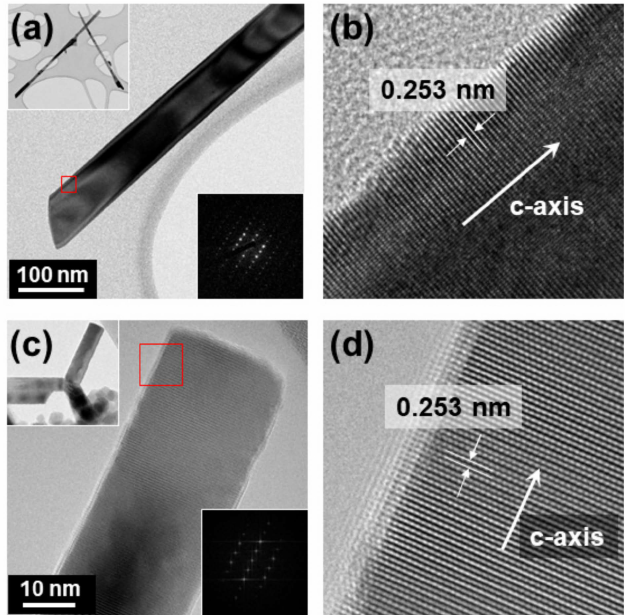
Figure 4. ( a ) TEM image of ZnO nanowire (inset: low-magnification image and SAD pattern). ( b ) High-magnification TEM image of ZnO nanowire at square area indicated in ( a ). ( c ) TEM image of ZnO tetrapod (inset: low-magnification image and FFT pattern). ( d ) High-magnification TEM image of ZnO tetrapod at square area indicated in ( c